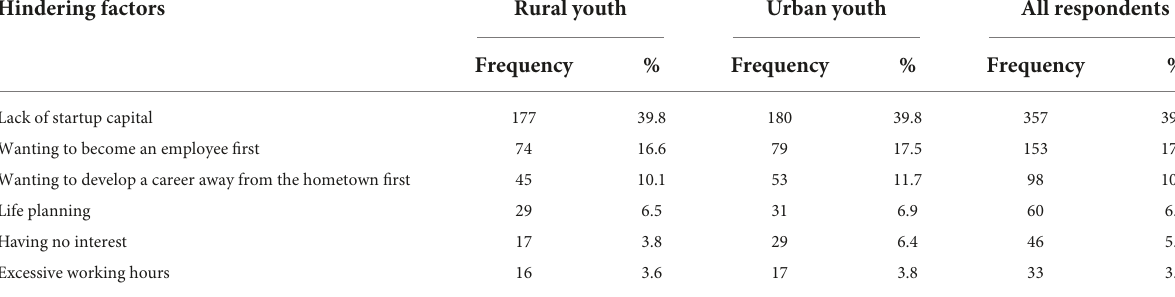
TABLE 10 Guidance on return-home